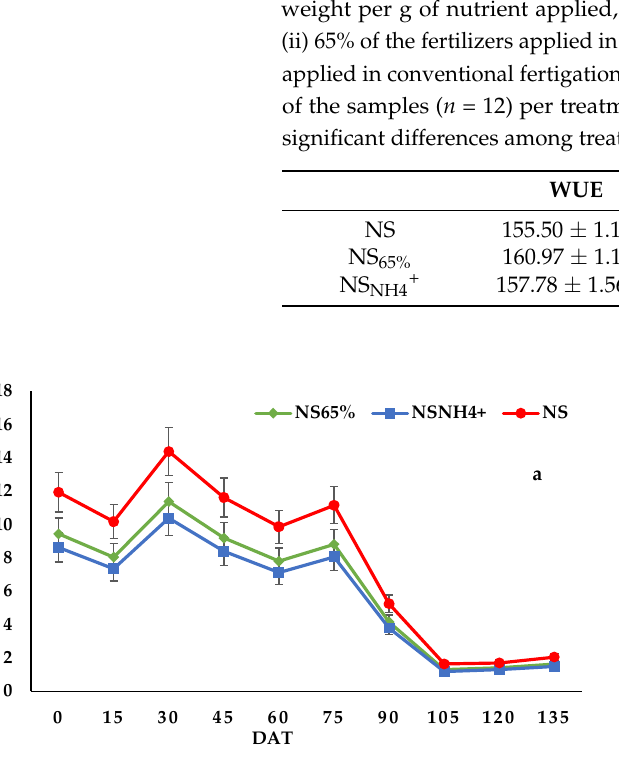
Table 4. Water and nutrient use efficiencies (WUE, expressed as g of marketable tomato fresh weight per liter of water applied, g L − 1 ) (NUE, PUE and KUE, expressed as g of marketable tomato fresh weight per g of nutrient applied, g g − 1 ). The treatments were: (i) conventional fertigation (NS);